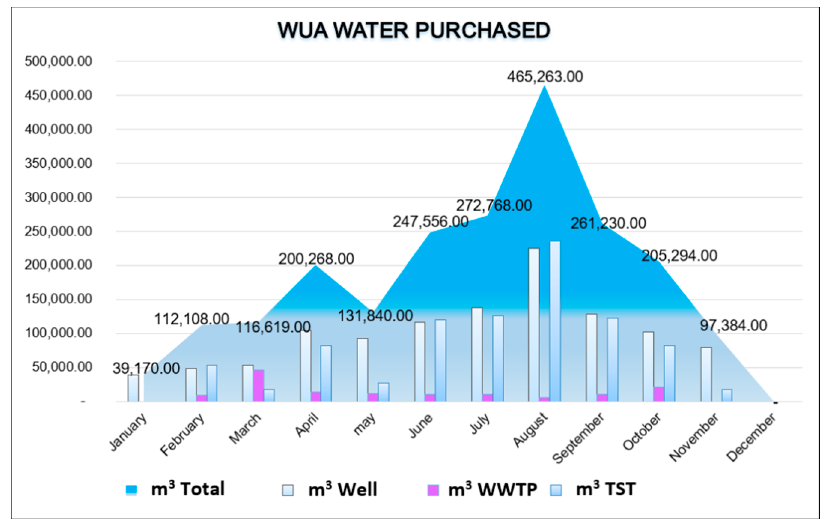
Figure 2. Monthly water purchased, according to the water supply source. Source: Own elaboration.